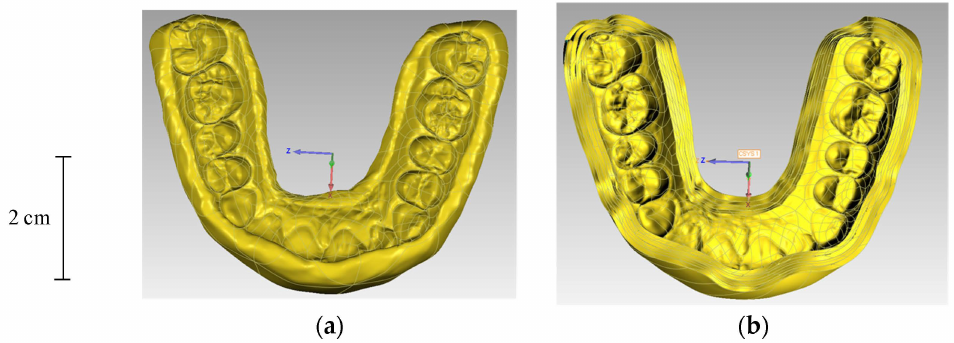
Figure 1. Geometrical model of two mouthguard protections: ( a ) Compact EVA Mouthguard (CMG); ( b ) Foam EVA Mouthguard